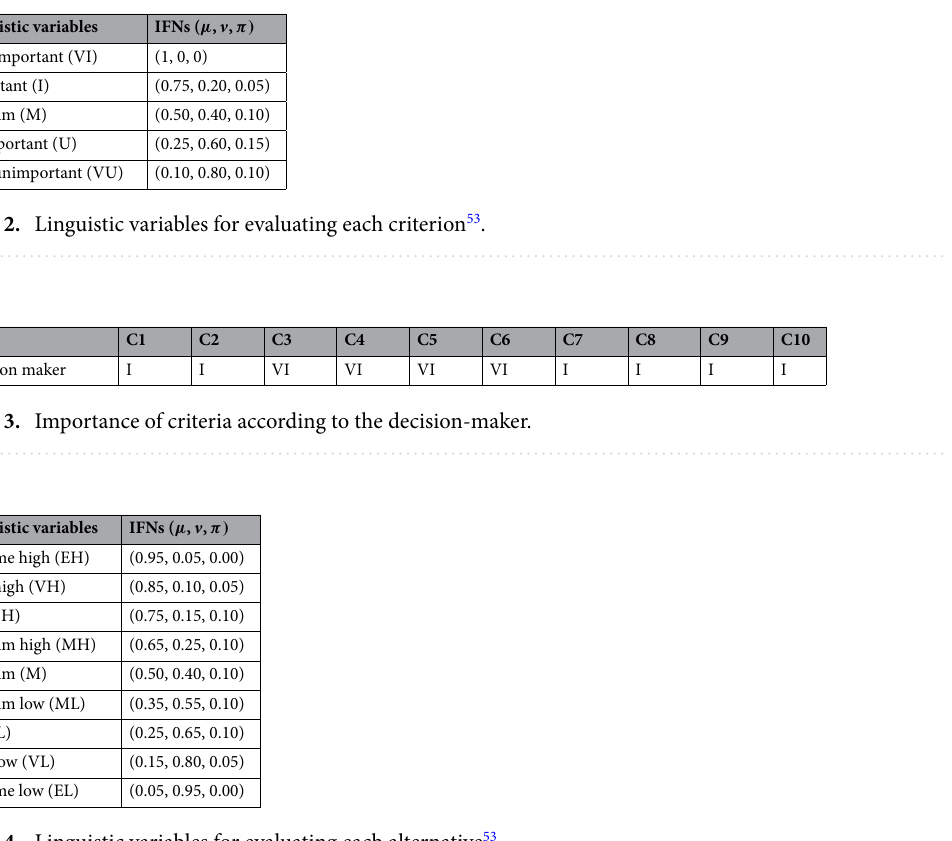
Table 4. Linguistic variables for evaluating each alternative 53 .